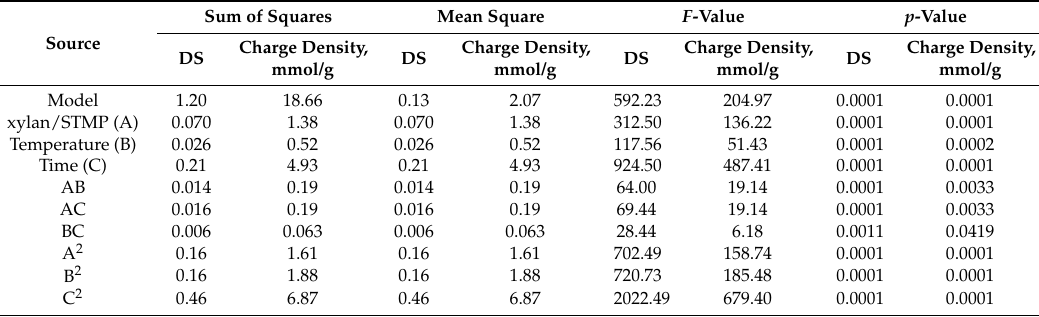
Table 2. ANOVA analysis for degree of substitute (DS) and charge density of phosphorylated xylan. Sum of Squares Mean Square F -Value p -Value Source DS